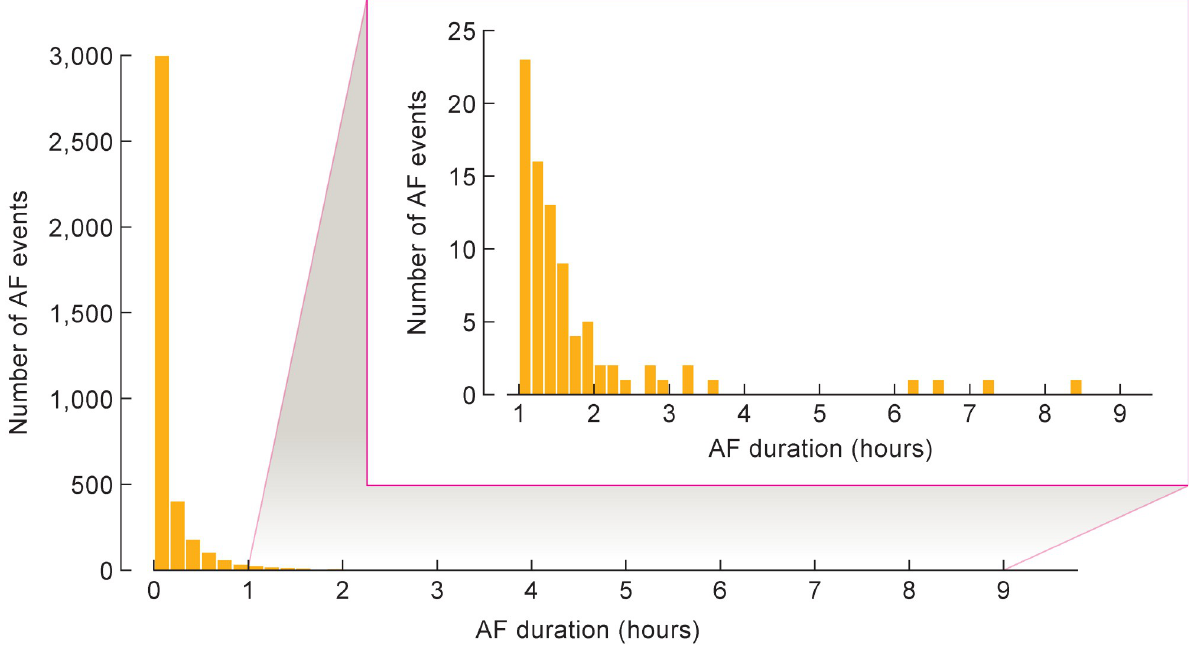
Fig 4. AF duration in the Garment ECG measurement period. AF, atrial fibrillation; ECG, electrocardiogram.